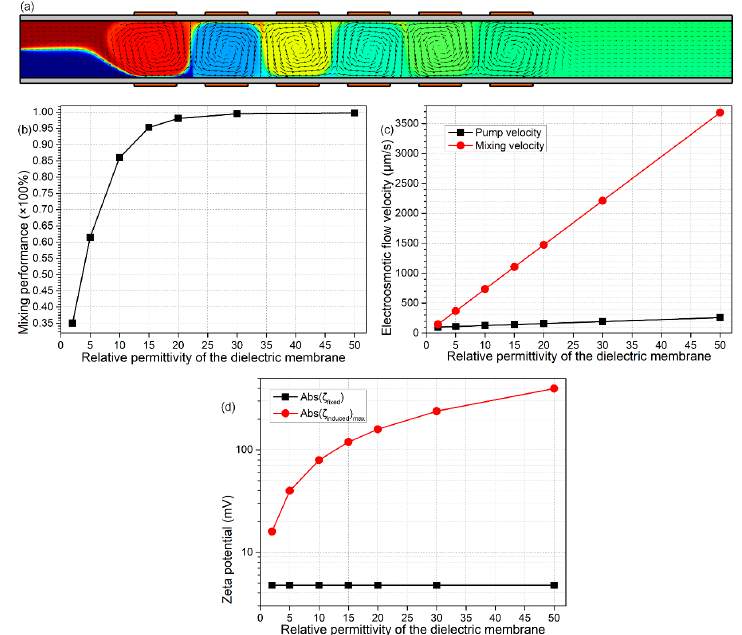
Figure 11 . Calculation results of the influence of the dielectric permittivity of the insulation membrane ε ins on the device performance of the sextuple-alternated B-DCFFET, under given values of Vs = 70 V, V G1 = − V G2 = 700 V, L G = 150 μm, L GG = 100 μm, W ins = 20 μm , σ f = 0.005 S/m and = –0.0002 C/m 2 . ( a ) An arrow and surface plot of electroconvective streamlines and analyte molar concentration distribution (unit: mol/m 3 ) with ε ins = 20ε 0 . ( b ) ε ins -dependent device mixing performance. ( c ) Electroosmotic pumping and mixing flow velocity for distinct membrane dielectric permittivity. ( d ) Comparison between the native zeta potential fixed ζ and maximum induced zeta potential maximum at the sidewall/medium interface, as a function of the relative permittivity of the dielectric layer.